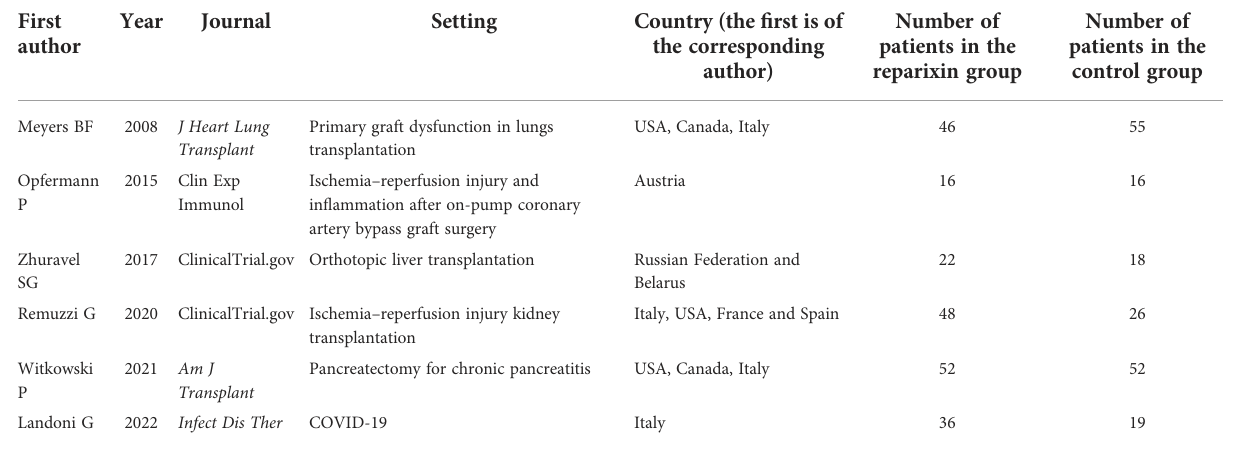
TABLE 1 Description of the studies included in the meta-analysis, in order of year of